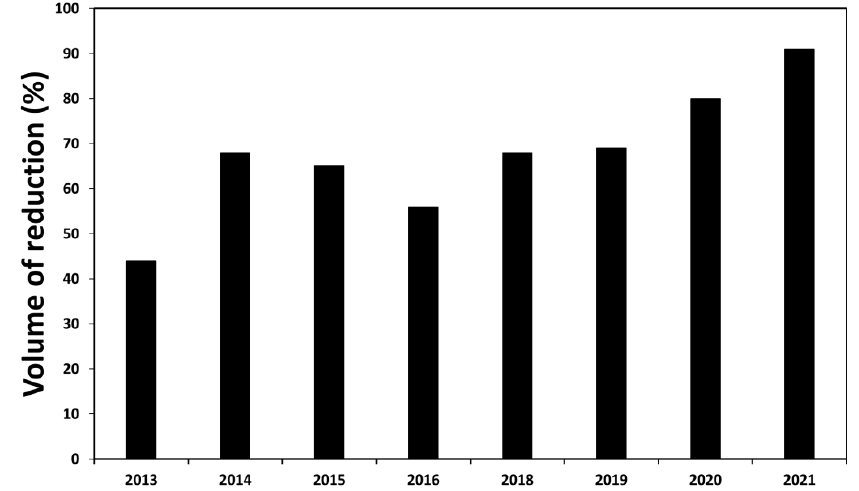
Figure 4. Volume reduction in the infiltration trench during the monitoring period.